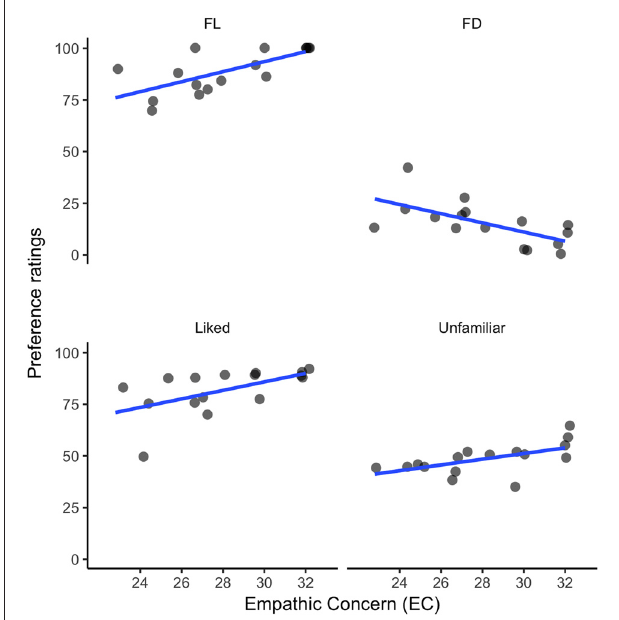
FIGURE 3 | Correlations between EC and musical preference: (1) ratings for familiar liked (FL) excerpts; (2) ratings for familiar disliked (FD) music; (3) ratings for all liked excerpts (familiar and unfamiliar); and (4) ratings for all unfamiliar music (liked and disliked).